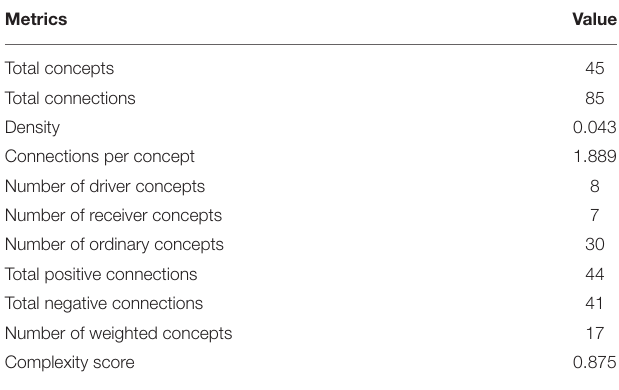
TABLE 1 | Summary statistics of the